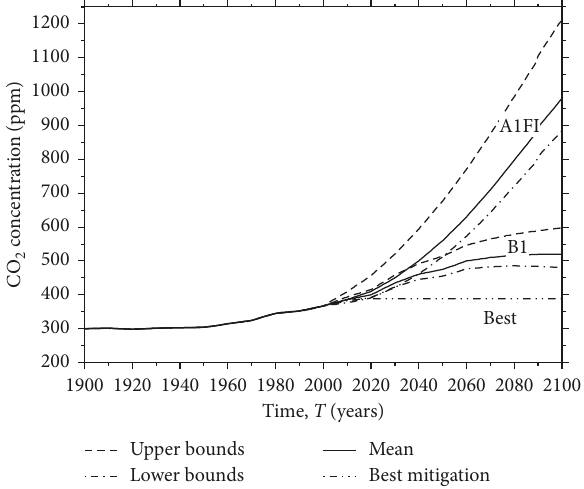
Figure 1: Time-dependent change of atmospheric CO